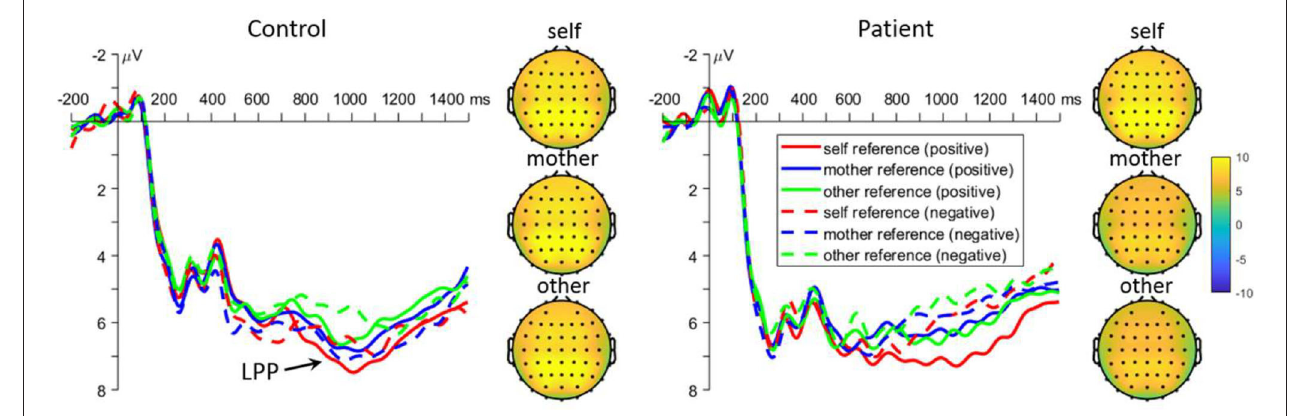
FIGURE 4 | Mean event-related potential waveforms and topographies in response to negative and positive self-, mother-, and other-referential stimuli among patients with first-episode schizophrenia and healthy controls during retrieval phase in parietal electrodes. Data were averaged across at Pz, CPz, P1, and